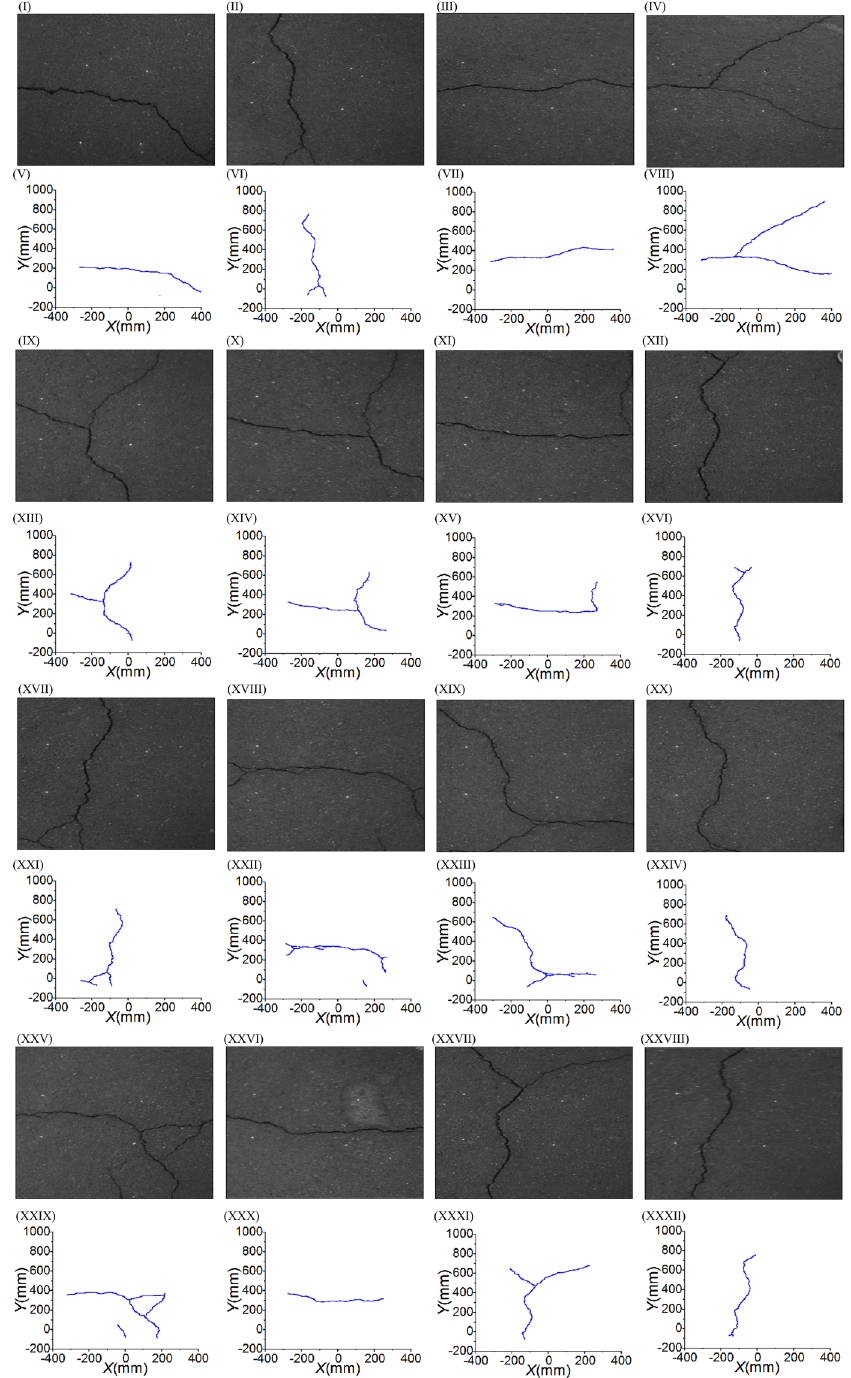
Figure 5. Recovery experiments of the pavement cracks that are achieved by the active solutions of the homographies. ( I )–( IV ), ( IX )–( XIl ), ( XVII )–( XX ), ( XXV )–( XXVIII ) are the eight images of the different pavement cracks. ( V )–( VIII ), ( XIII )–( XVI ), ( XXI )–( XXIV ), ( XXIX )–( XXXII ) are the recovery results of the different pavement